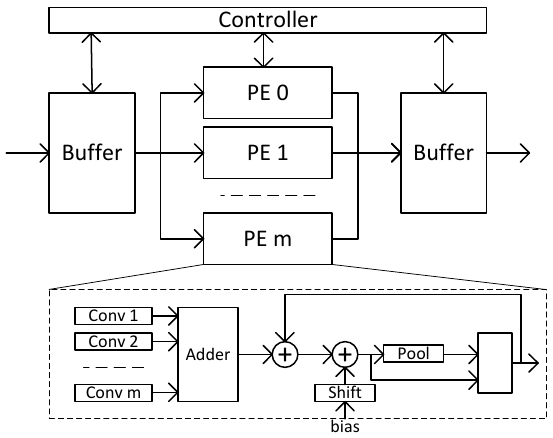
Figure 10. Architecture of Angel-Eye.